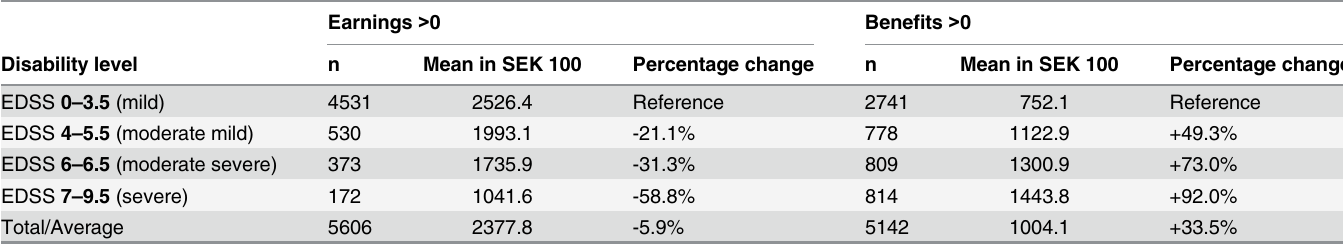
Table 2. The differences in level of income among MS patients by disability level.